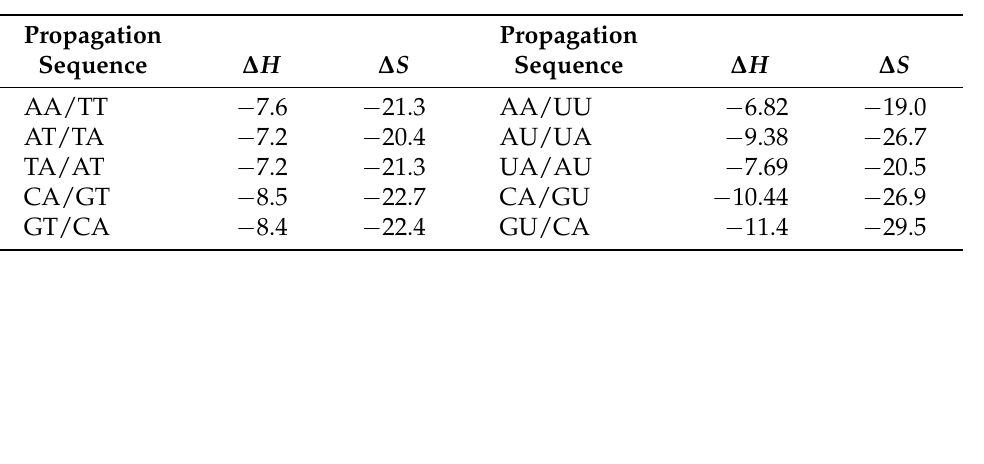
Table A1. Thermodynamic parameters for canonical Watson–Crick base pairs for duplexes made by DNA/DNA (left panel) and RNA/RNA (right panel). Energy and entropy units are kcal mol − 1 and cal mol − 1 K − 1 ,